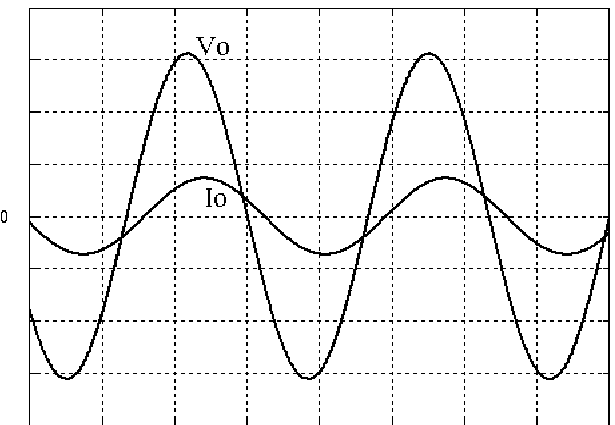
Figure 7. Simulated output waveforms with the proposed controller at inductive load (vertical: 50 V/div and 20 A/div; horizontal: 5 ms/div).